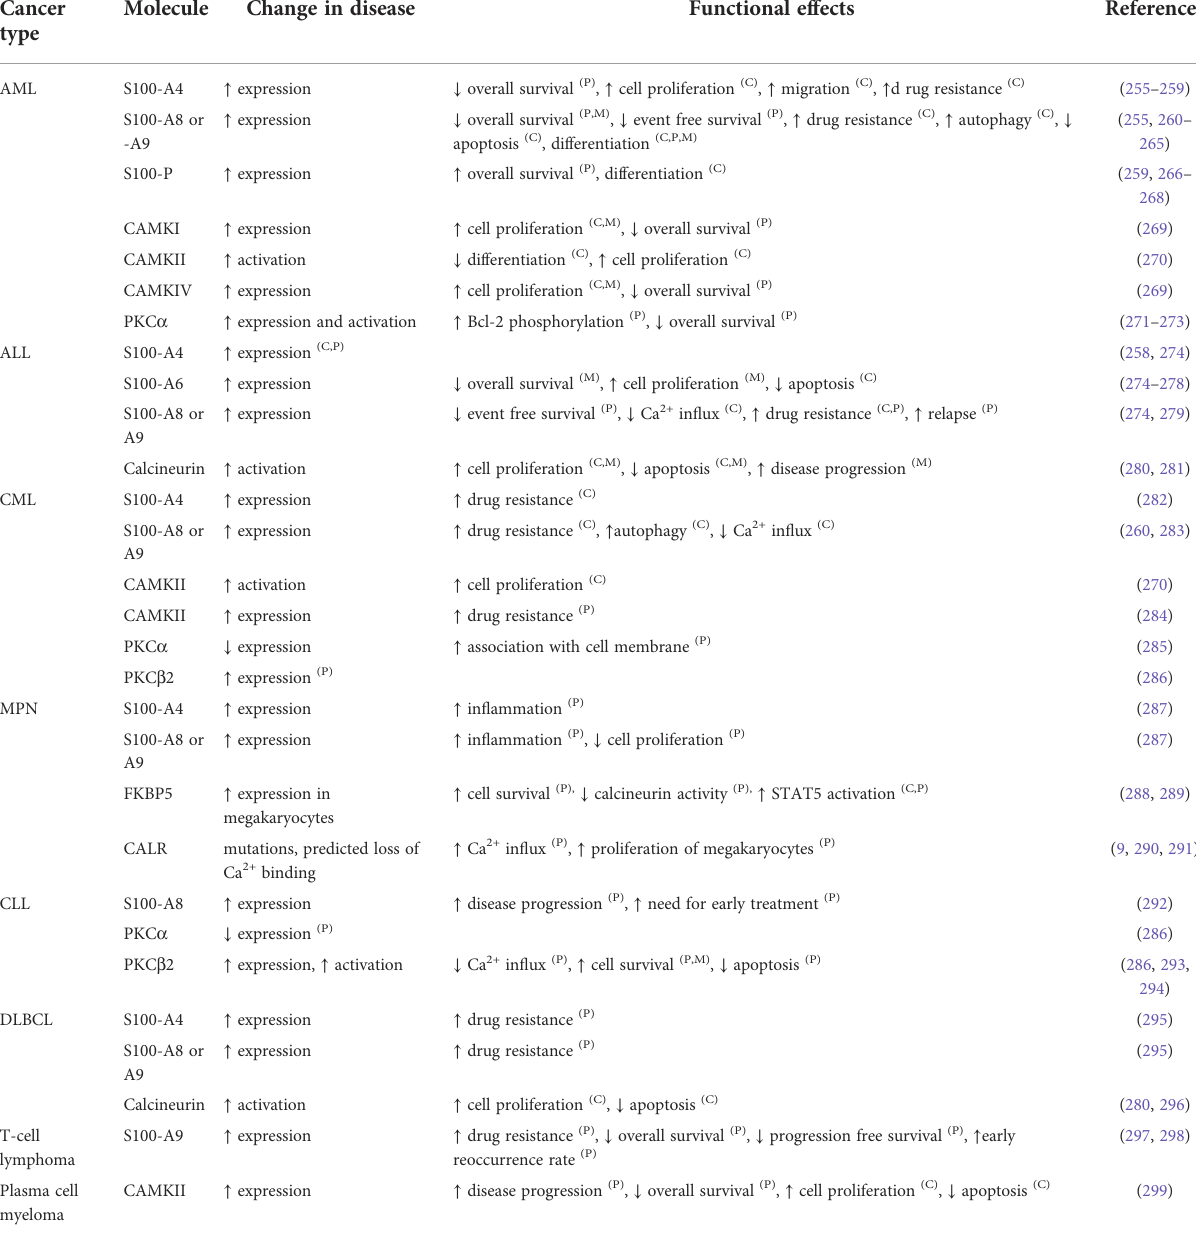
TABLE 2 The differential expression of calcium sensor and effector proteins and their relative contribution to the malignant phenotype of different blood cancers.